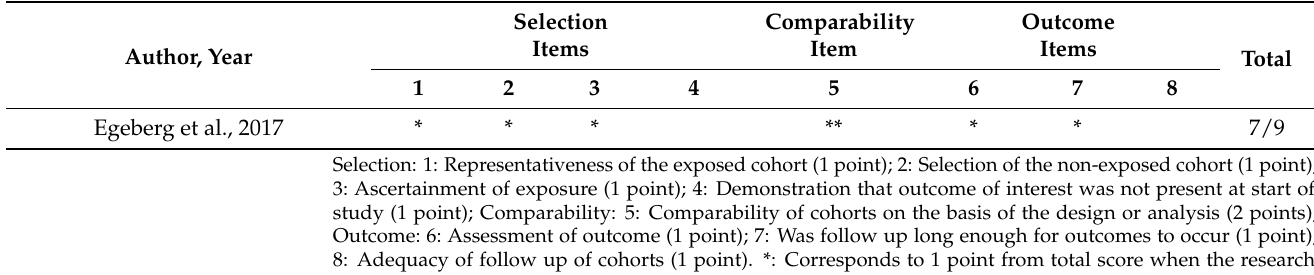
Table 3. Newcastle-Ottawa Scale for cohort